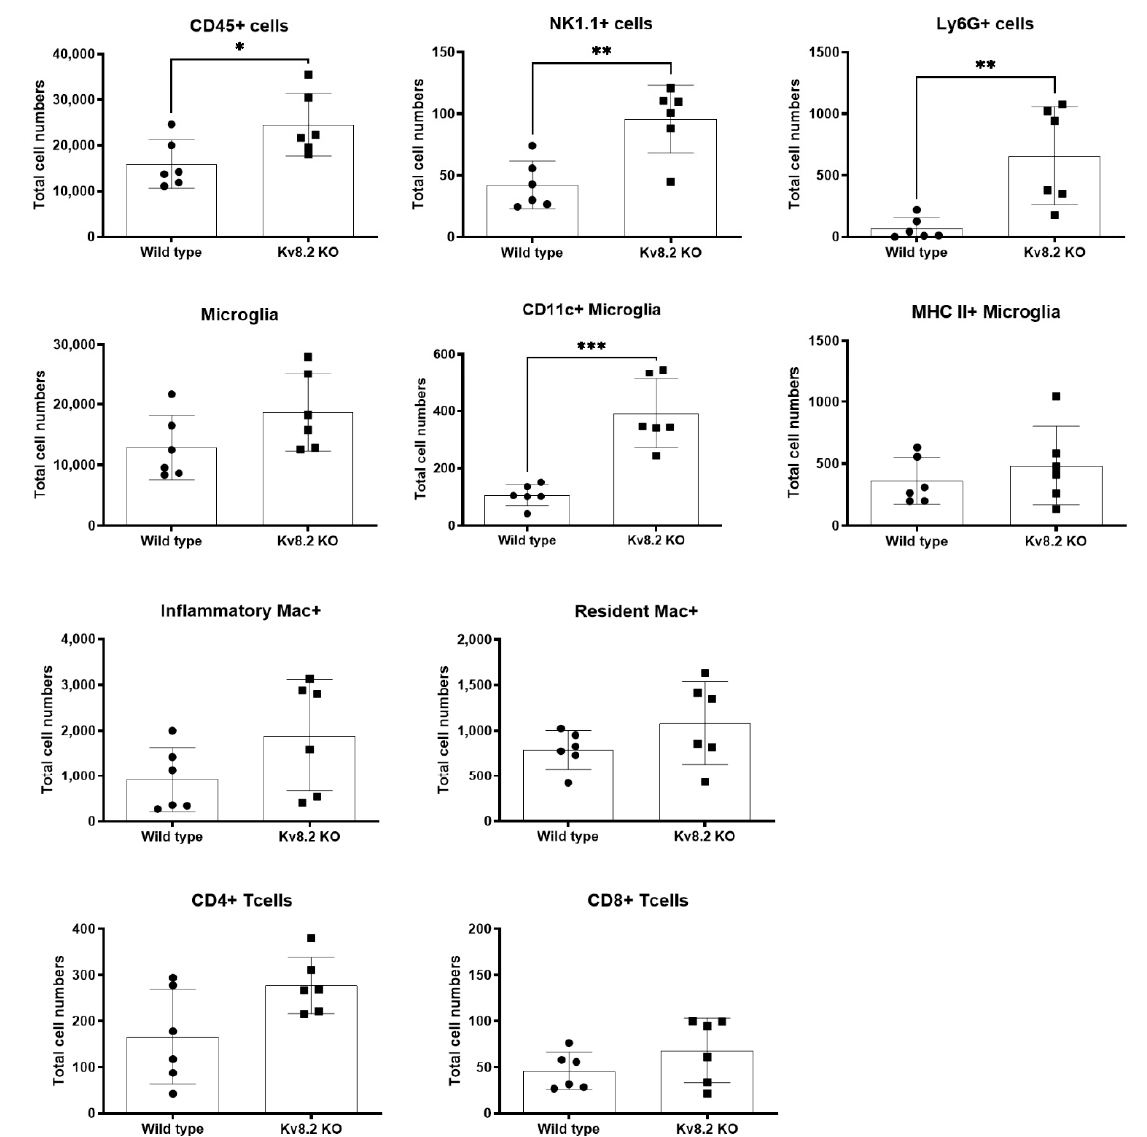
Figure 5. Characterization of immune cells present in the retina of wild type (WT) and Kv8.2 knockout (KO) mice. Panels show quantification of different types of immune cells in two-month-old WT and Kv8.2 KO retinas. Results are presented as mean +/ − SEM from n = 6. p values were obtained through unpaired t -test with Welch’s correction, * p = 00286, ** p < 0.0029 and *** p = 0.0002.